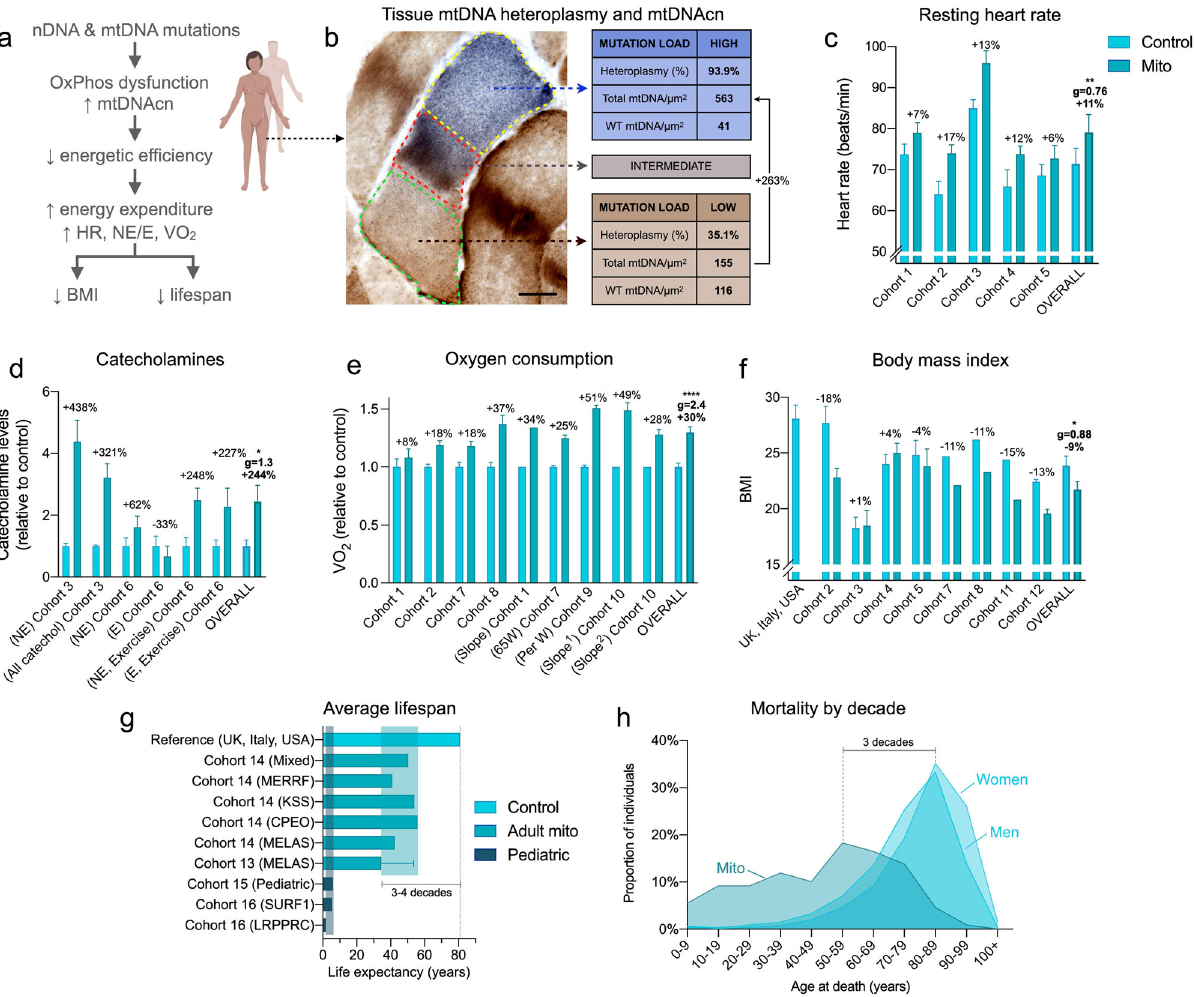
Fig. 1 Meta-analysis of human studies reveals increased energy expenditure and shortened lifespan in primary mitochondrial diseases. a Overall conceptual model linking mtDNA- and nDNA-related OxPhos defects to impaired metabolic ef fi ciency at the cellular level, impacting whole-body resting energy expenditure and clinical outcomes. b Skeletal muscle biopsy with individual muscle fi bers stained with cytochrome c oxidase/succinate dehydrogenase (COX/SDH) histochemistry to reveal functional (brown) and respiratory chain de fi cient (blue) mitochondria. In the affected cell (middle), three sub-regions showing low, intermediate, and high mtDNA mutation load were captured by laser capture microdissection and subjected to quantitative PCR analysis as in ref. 117 . Subcellular regions with high mtDNA mutation load show elevated mtDNA density, which is predicted to increase the energetic cost due to mitochondrial biogenesis and turnover processes. WT, wild type. c Meta-analysis of human mitochondrial disease cohorts showing elevated resting heart rate ( n = 104 controls, 111 patients), d catecholamines (urinary-Cohort 3 and blood-Cohort 6) at rest or during fi xed-intensity exercise ( n = 38 controls, 19 patients), e whole-body oxygen consumption measured by indirect calorimetry at rest or during the response to mild exercise challenge; one before training, two after training. Slope refers to the rate of increase in VO 2 relative to work rate, where a higher slope indicates increased energetic cost for a given work rate ( n = 56 controls, 78 patients). f Body mass index (BMI) across mitochondrial disease cohorts and compared to relevant national averages (USA, UK, and Italy combined) ( n = 285 controls, 174 patients). g Average life expectancy in individuals with mitochondrial diseases relative to the national average ( n = 301 patients). Data are means ± SEM, with % difference between mitochondrial disease and control group were available. h Mortality (age at death) over 10 years (2010 – 2020) in Cohort 17 compared to national averages for women and men ( n = 109 patients). See Table 1 for cohort details. Total n = 225 healthy controls, 690 patients. Only aggregate group means (with or without a measure of variance) were available for some cohorts, so individual participant data is not shown. Standardized effect sizes are quanti fi ed as Hedges ’ g ( g ). Overall group comparisons were performed by paired t tests ( c and f ) or one-sample t tests ( d and e ), * p < 0.05, ** p < 0.01, **** p <